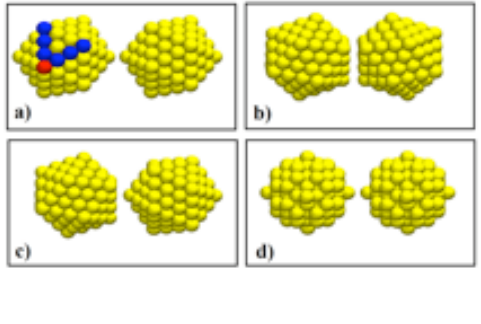
Figure 1. Different initial configurations used in the MD simulations. ( a ) I , h vertex-to-vertex; ( b ) I , facet-to-facet; ( c ) I , facet-to-vertex; ( d ) fcc quasi-spheres. The h h darker atoms on (a) define the order ν of the icosahedron; for an I of 147 atoms as the one h shown in the figure, ν = 3